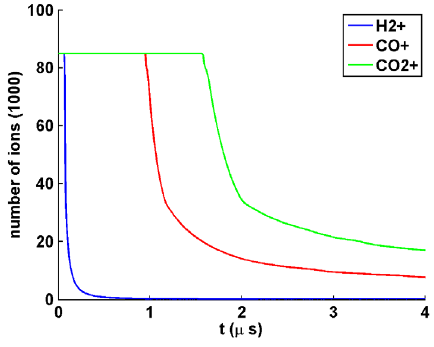
FIG. 21. Clearing times of ion clouds consisting of H þ 2 , CO þ , CO þ 2 ions around the beam potential of a 50 MeV bunch with Gaussian distribution and a repitition rate of 1